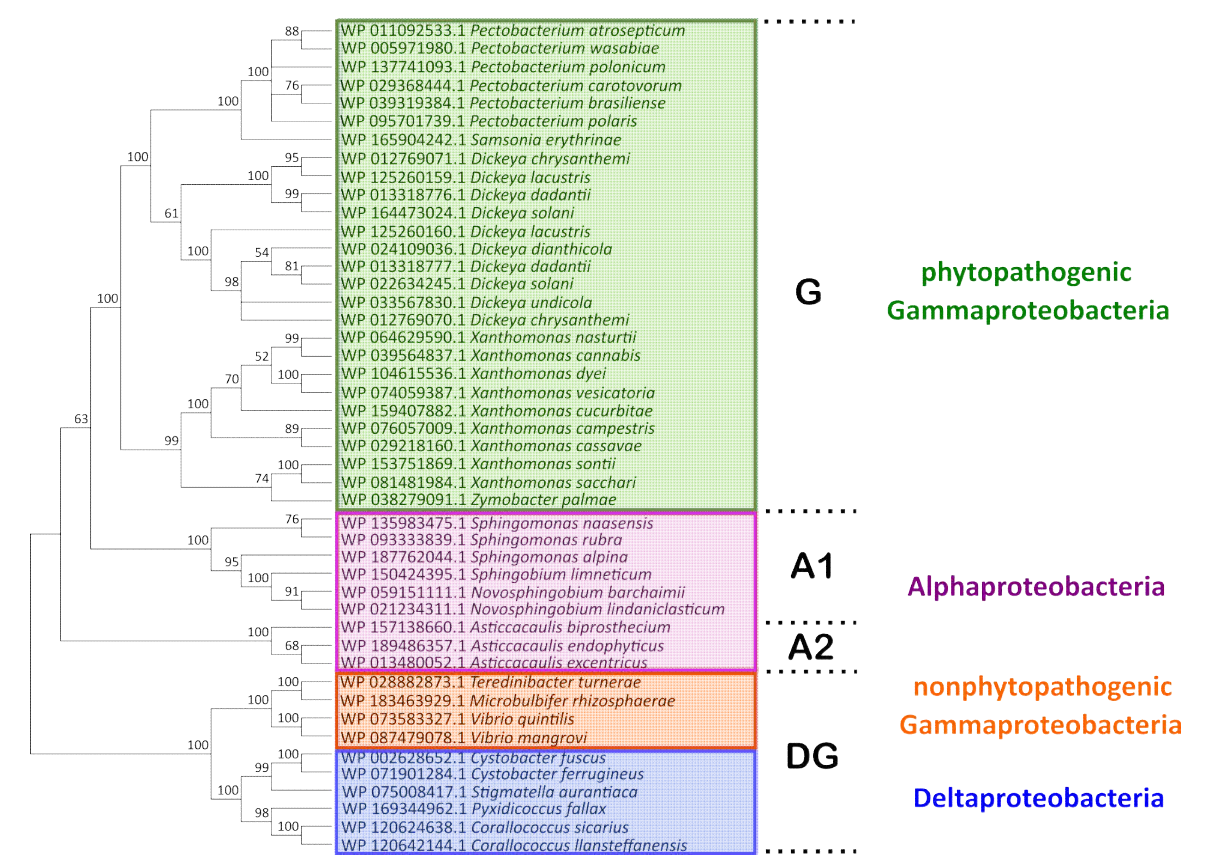
Figure 1. The phylogenetic tree of the amino acid sequences of Svx-like proteins. The sequences were obtained from the NCBI RefSeq Select Protein Database and aligned using the MAFFT algorithm and the BLOSUM62 substitution matrix. The cladogram was built using the Poisson model and the minimal evolution algorithm in MegaX. The statistical support of the phylogenetic tree was estimated by bootstrap analysis [26], with 1000 replicates. G, A1, A2, and DG designate separate clades described in the text.